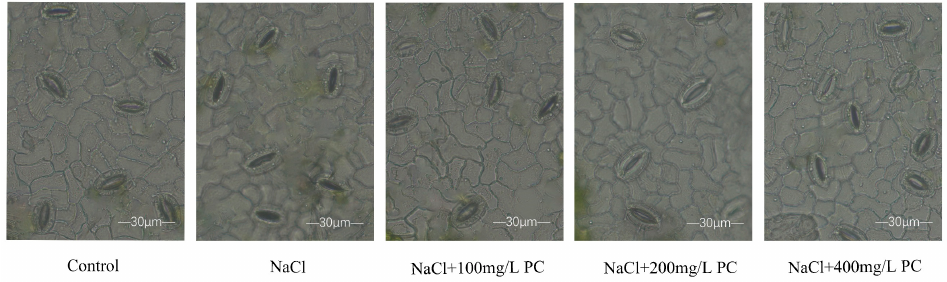
Figure 2. The cell stomatal size of peach tree leaves among different treatments. Measurements were performed using a light microscope to visualize peeled impressions of peach tree leaf epidermis. Peach tree leaf cell stomata were sampled and observed at 10:30 am on the 10th day of the treatment experiment. All samples are measured at approximately the same time of day. Bars correspond to 30 μ m. Table 1. Stomatal length, width, and area.